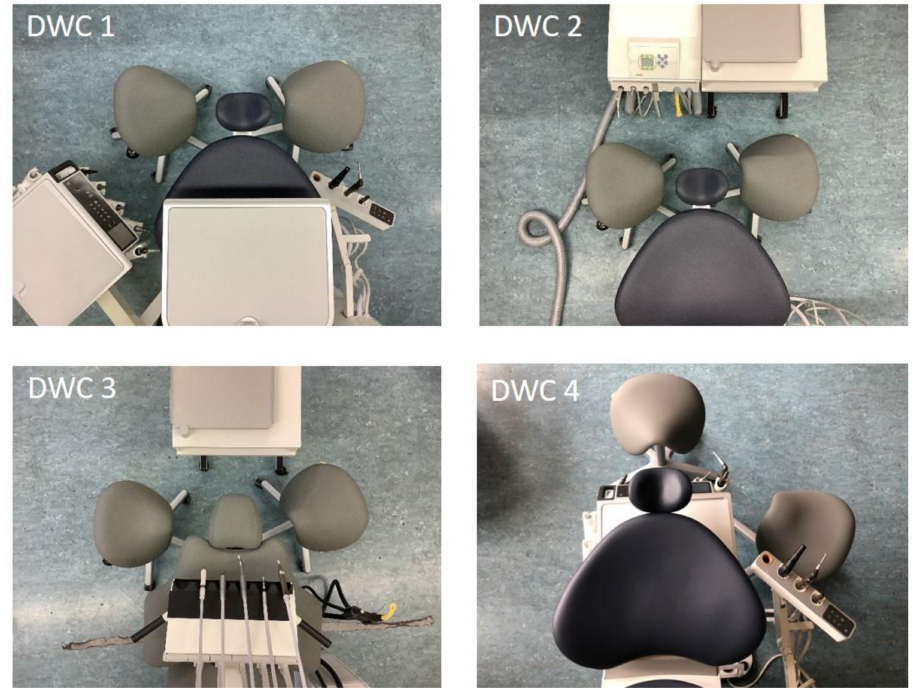
Figure 1. The different arrangements of the four dental workplace concepts